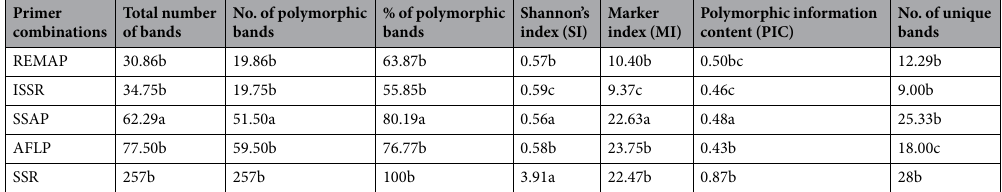
Table 6. Summary of the average genetic diversity parameters in Prunus species determined using a subset of the most efficient 7 REMAP, 4 ISSR, 7 SSAP, 2 AFLP and 32 SSR markers. Different letters represent statistically